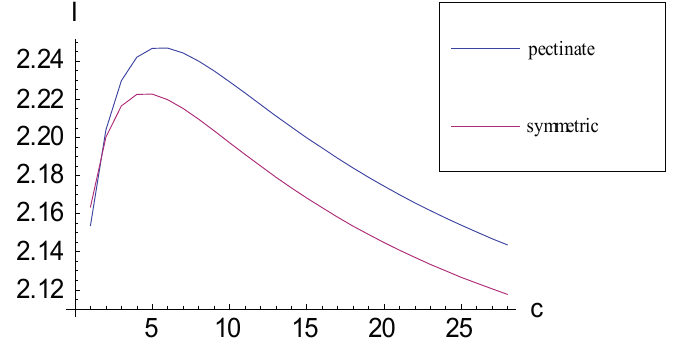
Figure 3. Plots relating information measure I and added autapomorphic characters c for consistent basal matrices (10.1) (pectinate) and (10.2) (symmetric). An upper bound to I